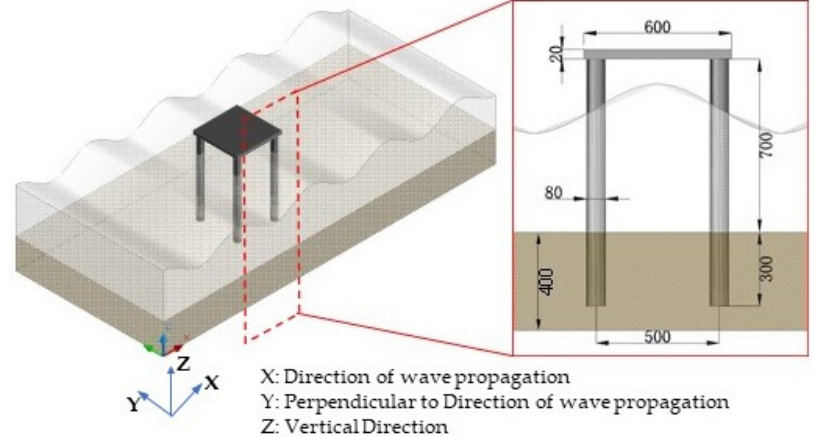
Figure 3. Schematic diagram of the model size and installation of the offshore platform.